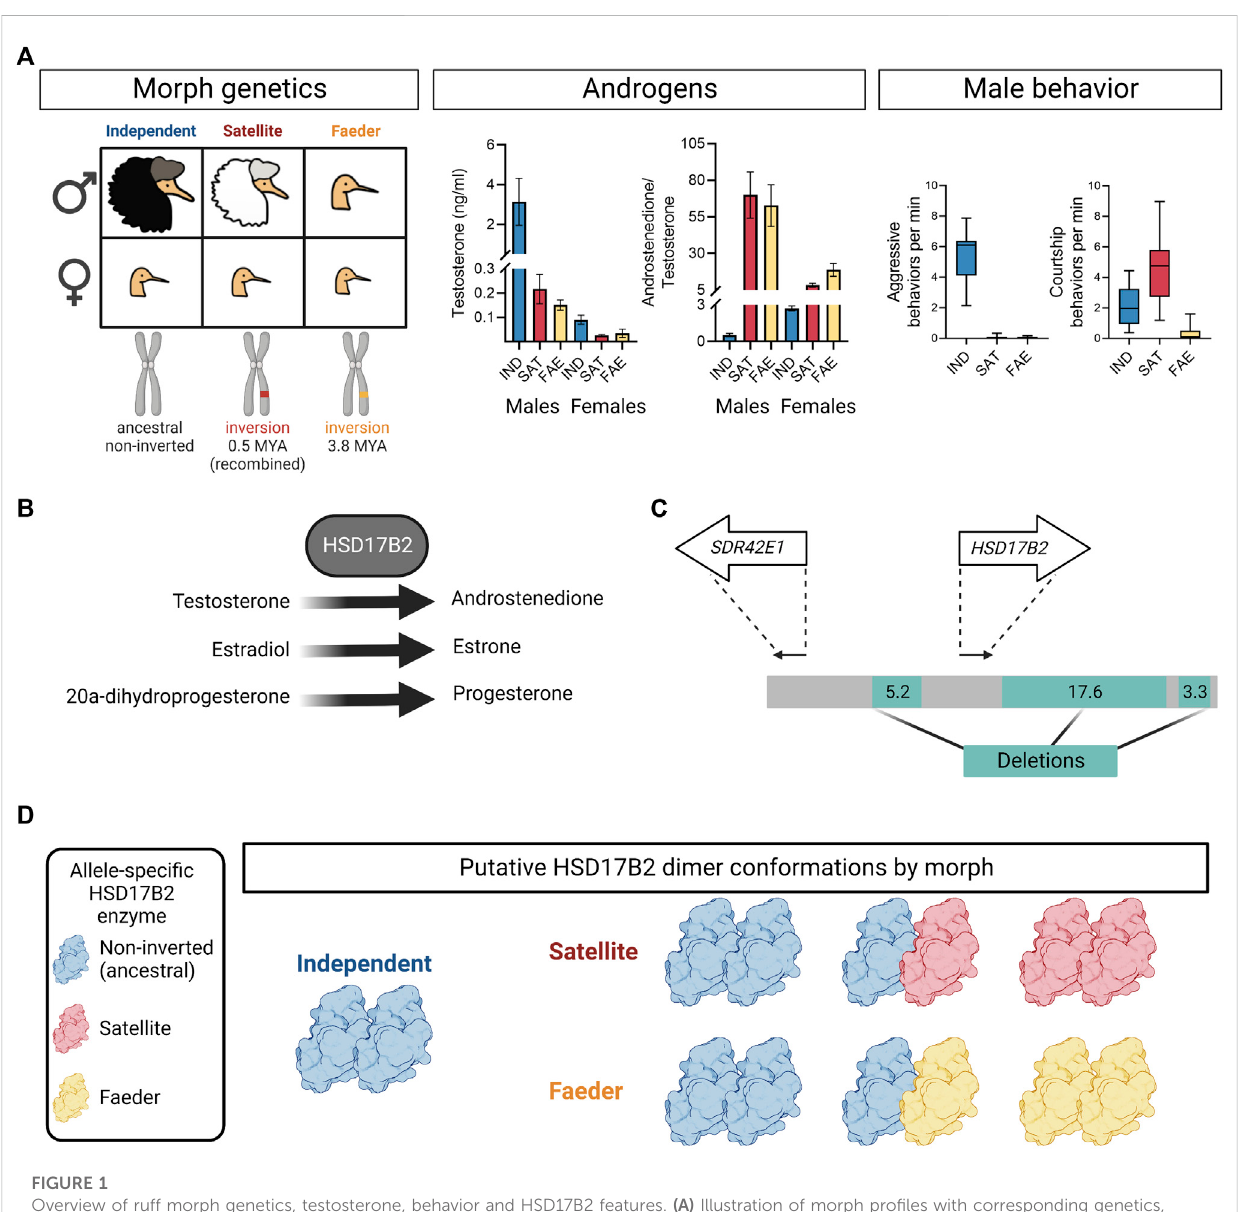
FIGURE 1 Overview of ruff morph genetics, testosterone, behavior and HSD17B2 features. (A) Illustration of morph pro fi les with corresponding genetics, circulating testosterone levels, androstenedione to testosterone ratio, and male behavior during the breeding season. In males, Independents and Satellites are ornamented, while Faeders are not. Satellites and Faeders are carriers of distinct inversion haplotypes on chromosome 11, thus present in both sexes. The Faeder inversion occurred 3.8 million years ago (MYA) and the Satellite inversion appeared ~0.5 MYA due to a recombination event between Independent and Faeder alleles. In both sexes, inversion morphs have lower circulating levels of testosterone and higher androstenedione to testosterone ratio, compared to Independent counterparts. Error bars are ± SEM. The y -axis breaks were introduced to provide informative detail. Boxplots show only Independent males aggressively defend territories and both Independents and Satellites actively court females, often with co- displays. Independent, IND; Satellite, SAT; Faeder, FAE. Plotted sample sizes in order Independent, Satellite, Faeder for testosterone in males: 17, 9, 9; females: 7, 5, 3; for androstenedione to testosterone ratio in males: 10, 7, 7; females: 5, 3, 3 [Data from (Loveland et al., 2021a) and females were processed in parallel]. (B) The HSD17B2 enzyme catalyzes with high af fi nity testosterone to androstenedione, estradiol to estrone and also with lower af fi nity, 20-alpha-dihydroprogesterone to progesterone. (C) Illustration of deletions (green) surrounding HSD17B2 and SDR42E1 genes inside inversion haplotypes. Both Faeder and Satellite haplotypes have these deletions. Arrows depict relative locations of SDR42E1 and HSD17B2 genes orientedin their direction of transcription. Numbers denote deletion sizes in kilobases. Redrawn based on (Lamichhaney et al., 2016). (D) Putative HSD17B2 dimer conformations by morph. As inversion heterozygotes, Satellites and Faeders are expected to express two HSD17B2 alleles: non-inverted (blue) and inversion (red, Satellite; yellow, Faeder) alleles. Therefore, if HSD17B2 acts in a dimer conformation, then Satellites and Faeders may have up to three possible dimer assemblies due to their heterozygosity, whereas Independents have only one possible homodimer. Solely for illustration purposes PDB ID: 6MNE was used in lieu of a crystal structure for